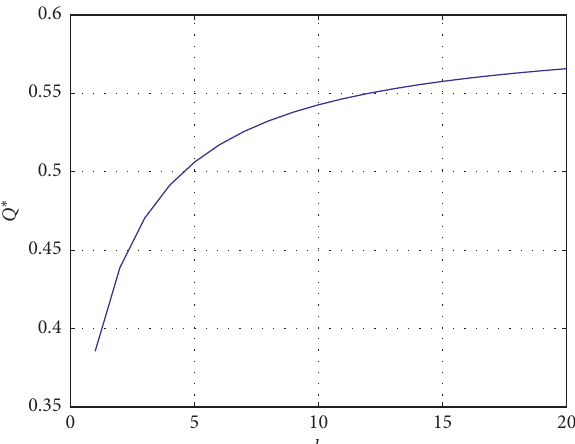
Figure 9: Effect of unit shortage cost b on the optimal inventory quantity Q ∗ under RMI mode with stochastic demand in the water supply chain.